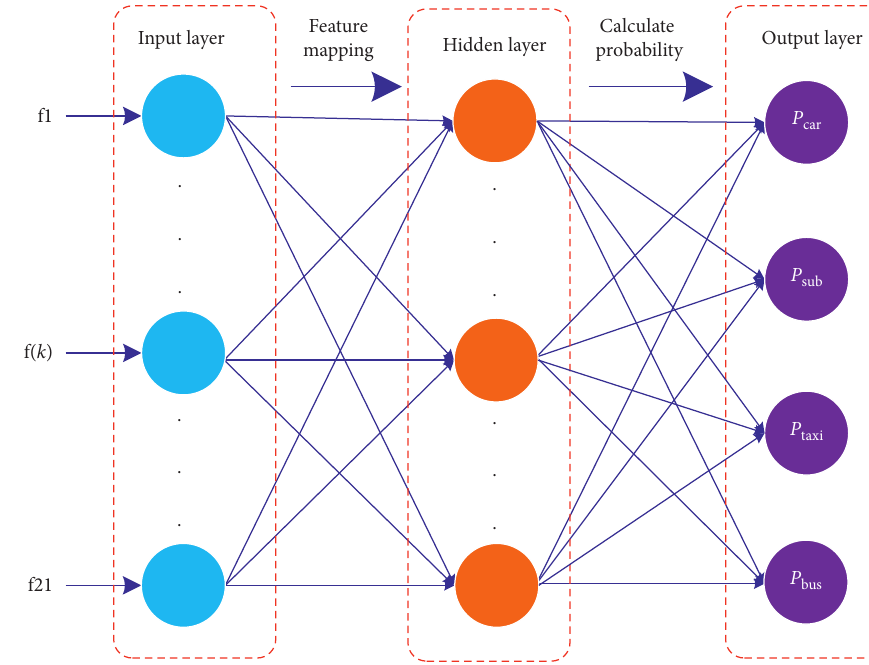
Figure 3: Schematic of the FCN.